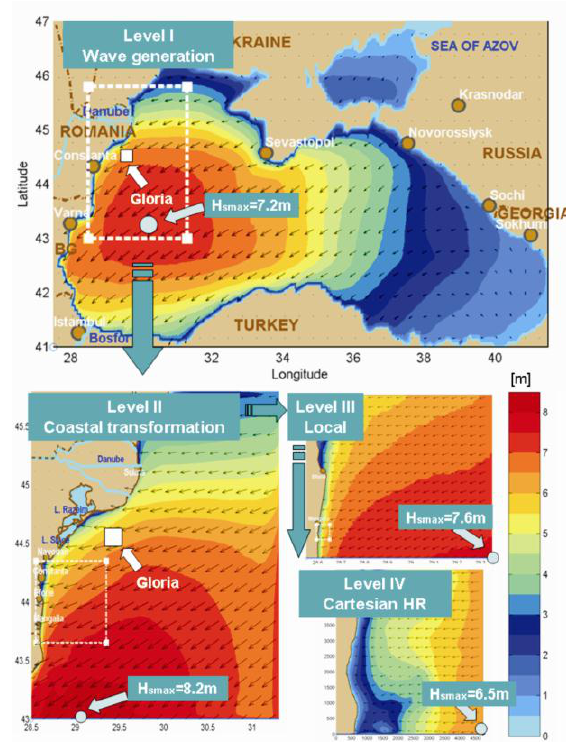
Fig. 1. Model focusing towards the western coast, significant wave height fields and wave vectors, case study corresponding to the time frame 2002/03/11/h18, typical storm